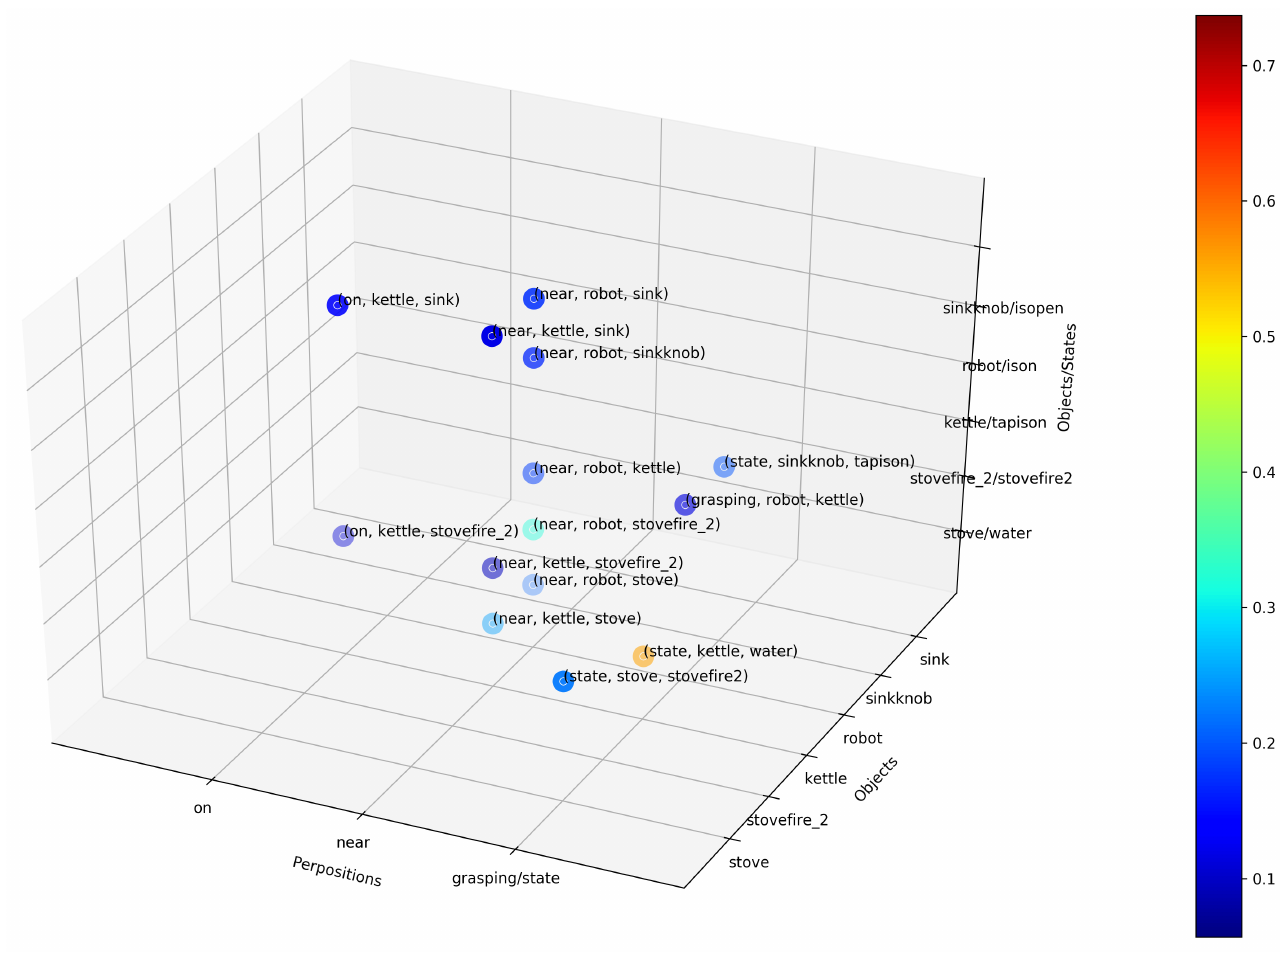
Figure 10: The value of each predicate is examined. For example, ( state, kettle, water ) has the highest value since it appears early in the optimal sequence of actions for the boiling water task and it lasts until the end as it is part of the terminal